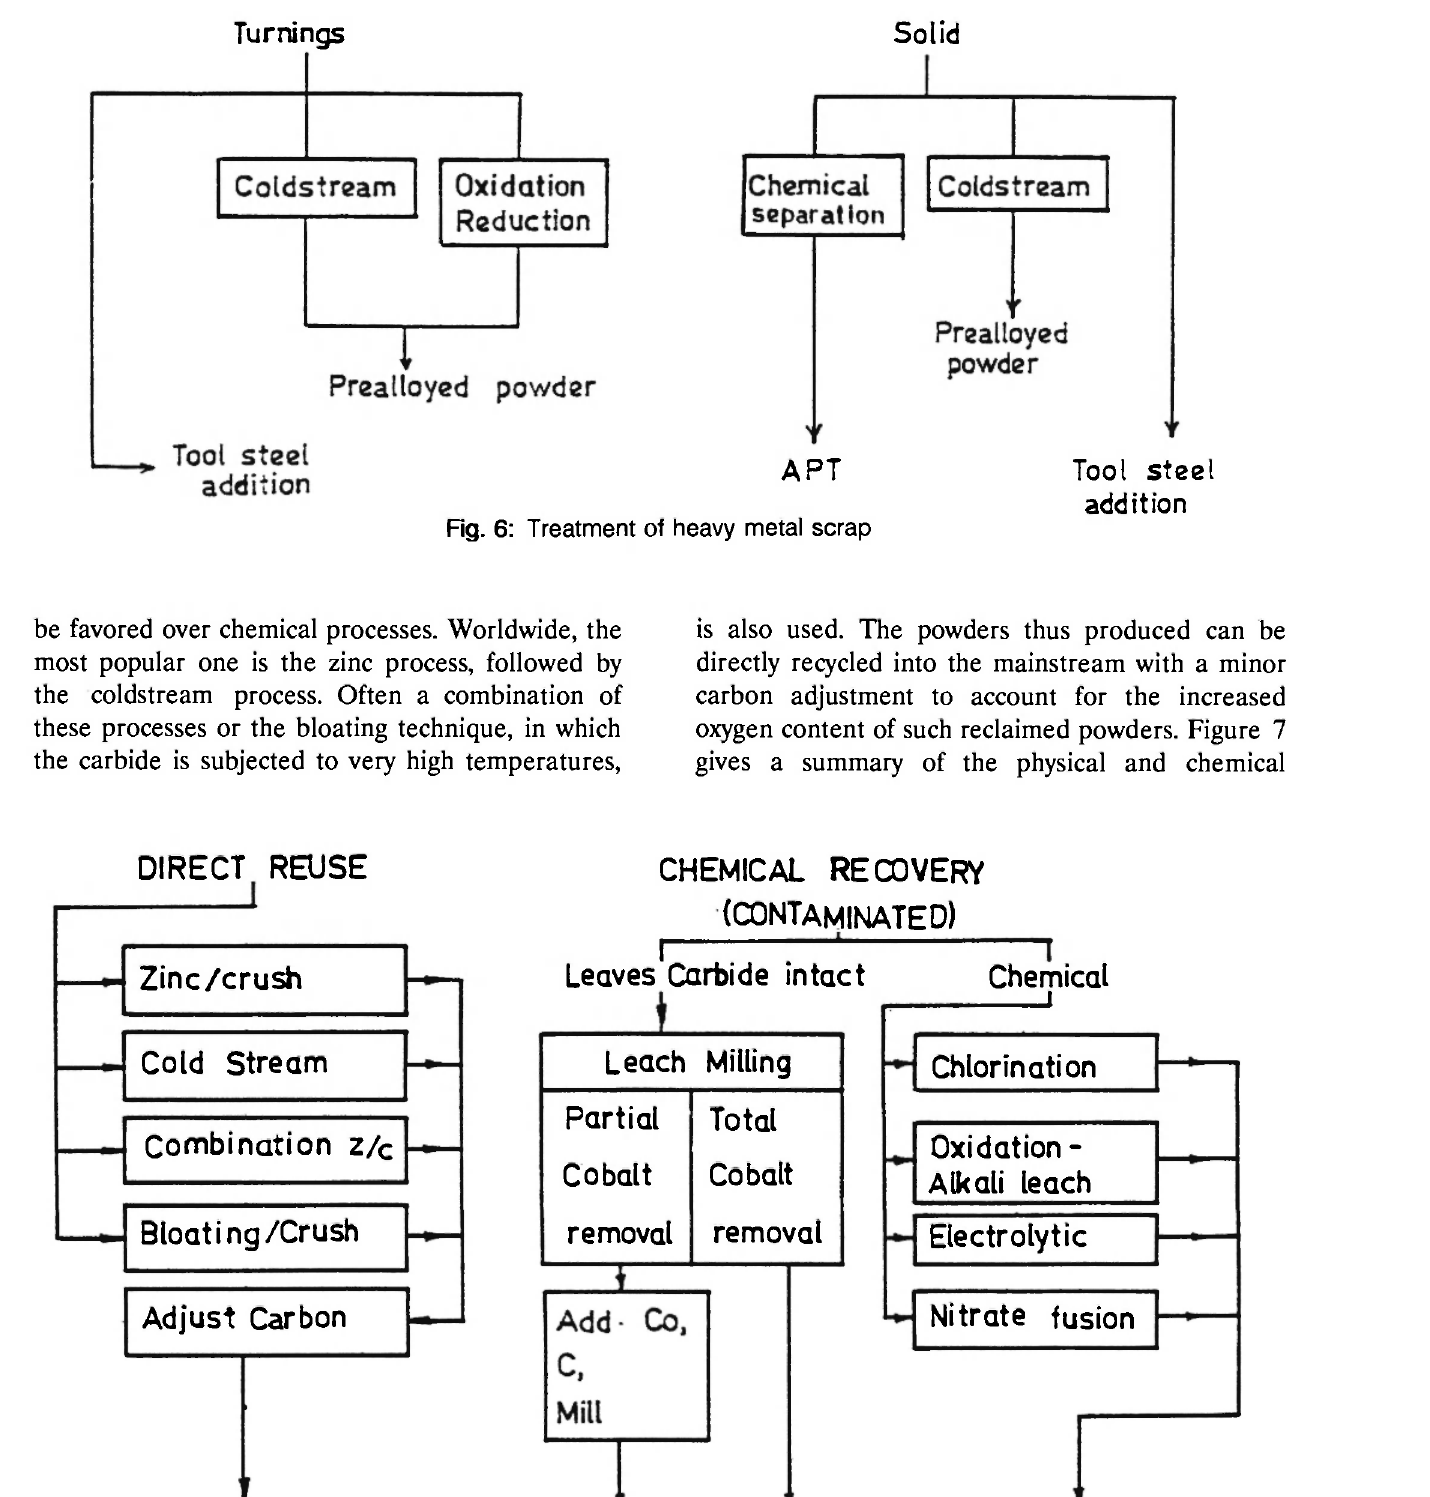
Fig. 7: Treatment of cemented carbide